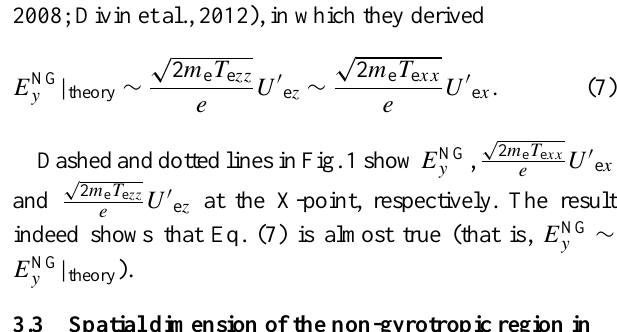
q q − 1 − 1 2 e d i = β 3 / 8 e 2 e d e 1 + αβ 1 + αβ